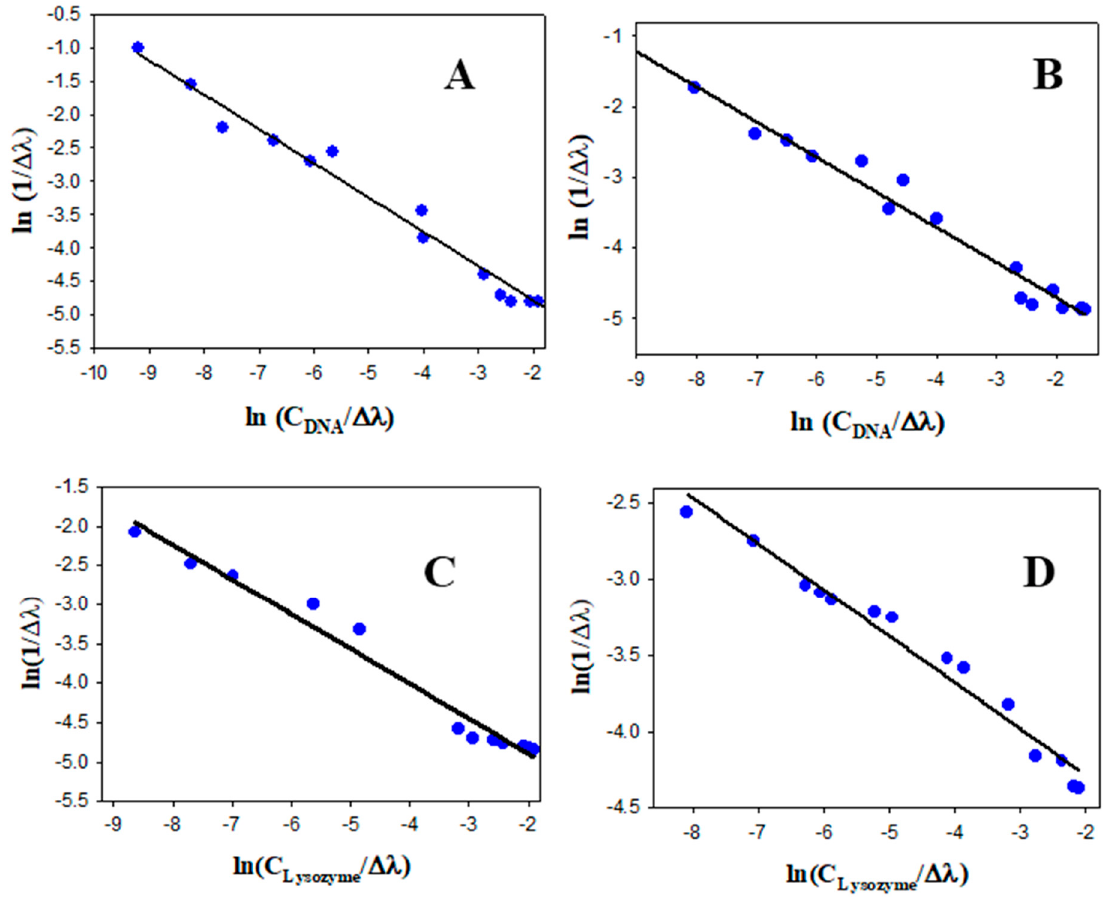
Figure 9. Colorimetric response patterns obtained with colorimetric sensors in water, showing the linear relationship between 1/ ∆λ 2 logarithms and the logarithms of the quotient between biopolymer concentration and ∆λ 2 . ( A ) Au@16-3-16/SDS/DNA system. ( B ) Au@16-6-16/SDS/DNA system.